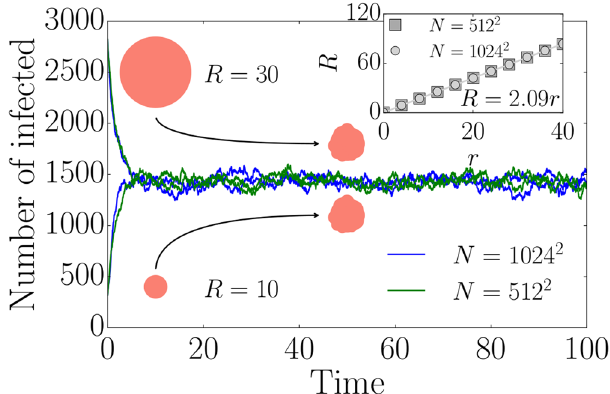
Figure 1. Time evolution and radius of the confined region. The number of infected nodes as a function of time for = r 10 , ε = 1 and two different initial circular spreading seeds. In the stationary state, the epidemic is still confined to a deformed circular spot. The inset shows the spreading radius π = R n r N ( ) / region as a function of the spreading rate r . All simulations have been performed on square lattices with N nodes and a circular spreading